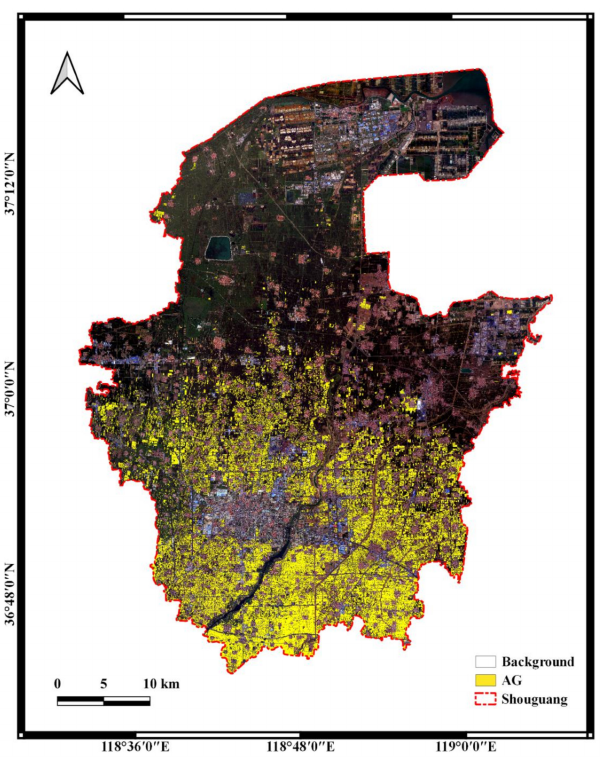
Figure 14. The distribution map of AGs in Shouguang District.